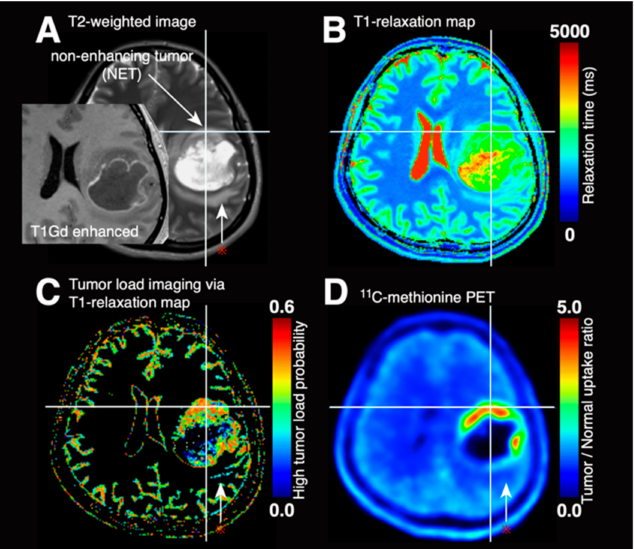
Figure 4. Synthetic tumor load image via T1-relaxometry. A representative case (case #11) of synthetic tumor load imaging is presented. Reference images of contrast-enhanced T1-weighted imaging and T2-weighted imaging are shown ( A ), alongside the raw T1-relaxation map ( B ). High tumor load probability maps are synthesized from T1-relaxation maps ( C ). 11 C-methionine PET uptake is shown as a reference for ground truth ( D ). It is readily appreciated that there are two types of T2-hyperintense regions and that synthetic tumor load maps correlate well with 11 C-methionine PET in those areas. The red asterisk indicated T2-hyperintense with a low tumor